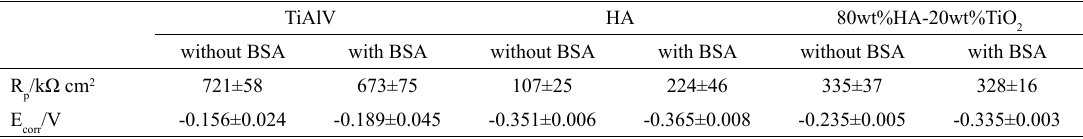
, E values for grit blasted TiAlV and as-sprayed HA-coated samples obtained after 24 h immersion in Hanks’ solution Table 2. R p corr without and with 4.2 g L -1 of BSA, at 37 °C. TiAlV